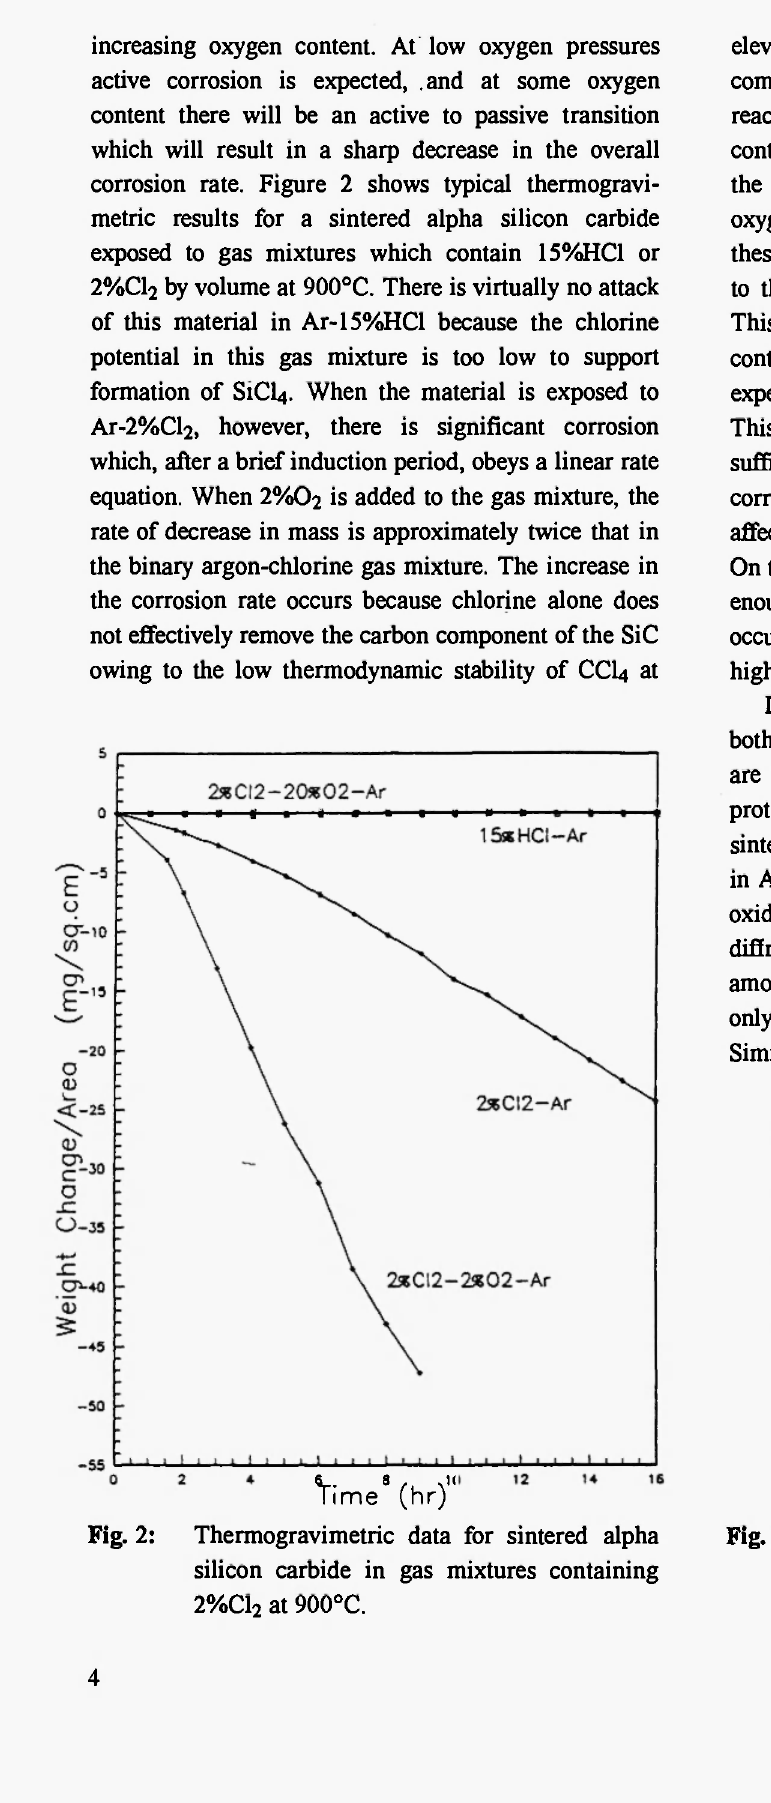
Fig. 3: Scanning electron micrograph of SASC specimen after exposure to Ar-2%Cl2-2%0 at